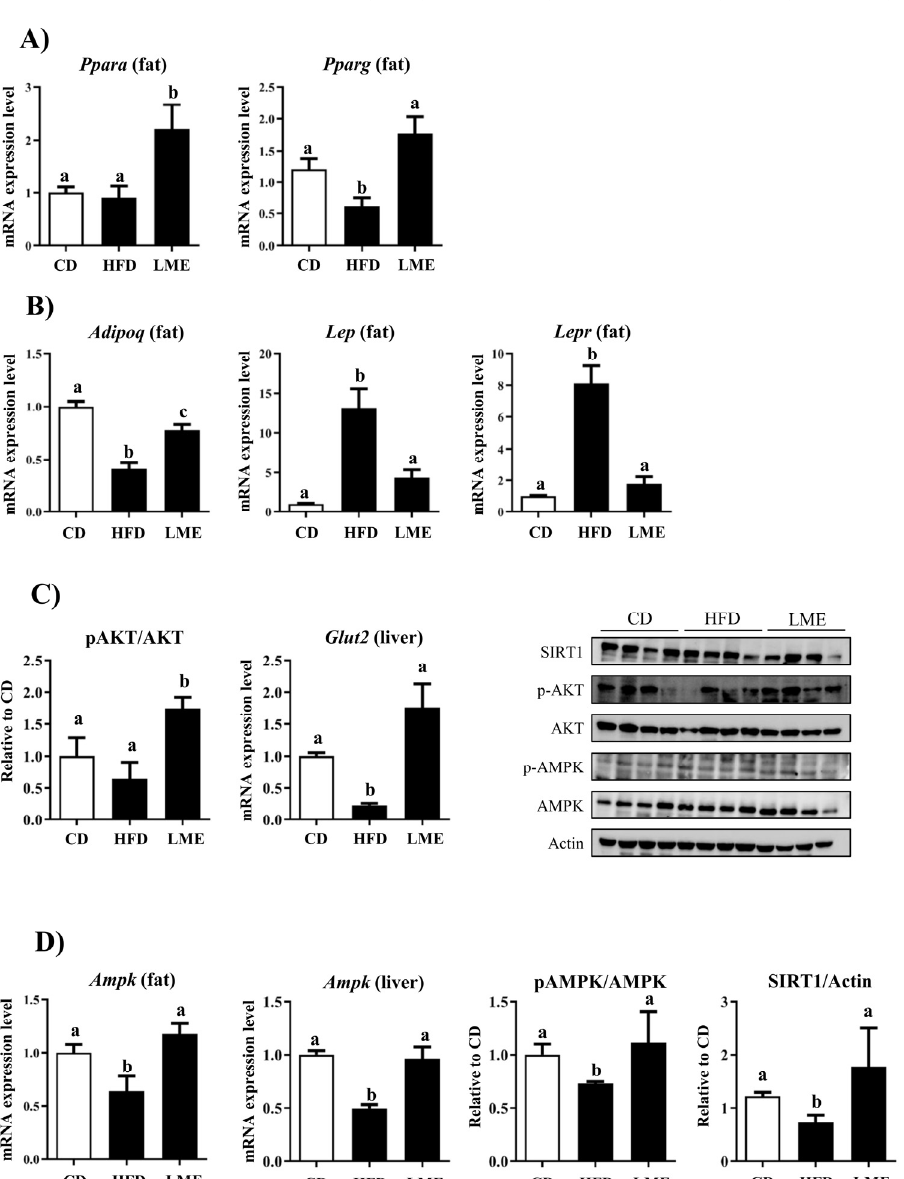
Figure 8. Effects of LME supplementation on fat and liver gene expression of ( A ) Ppar α and Ppar γ , ( B ) Adopoq , Lep, and Lepr , as well as ( C ) Glut2 , pAKT/AKT ratio, ( D ) Ampk gene expression, pAMPK/AMPK and SIRT1 protein levels in control (CD), and high-fat diet (HFD)-fed mice, analyzed using real-time qPCR or western blot. Data are expressed as means ± SEM ( n = 8). Groups with different letters statistically differ ( p < 0.05).